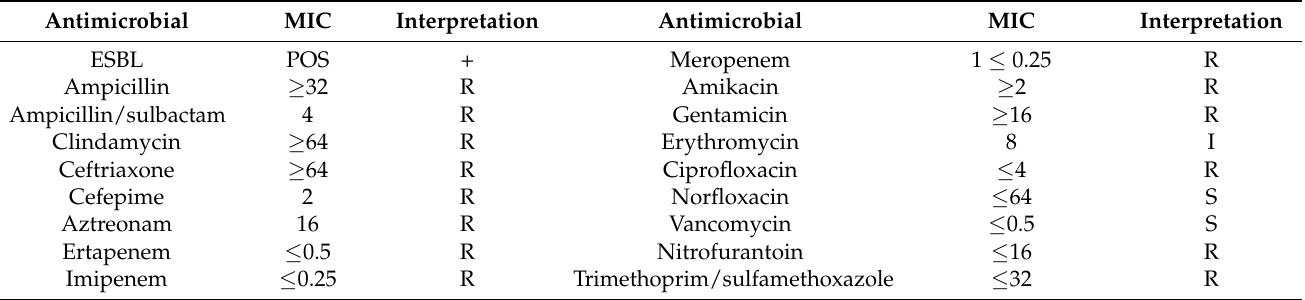
Table 5. VITEK 2 system for the identification and susceptibility testing of Pseudomonas aeruginosa .